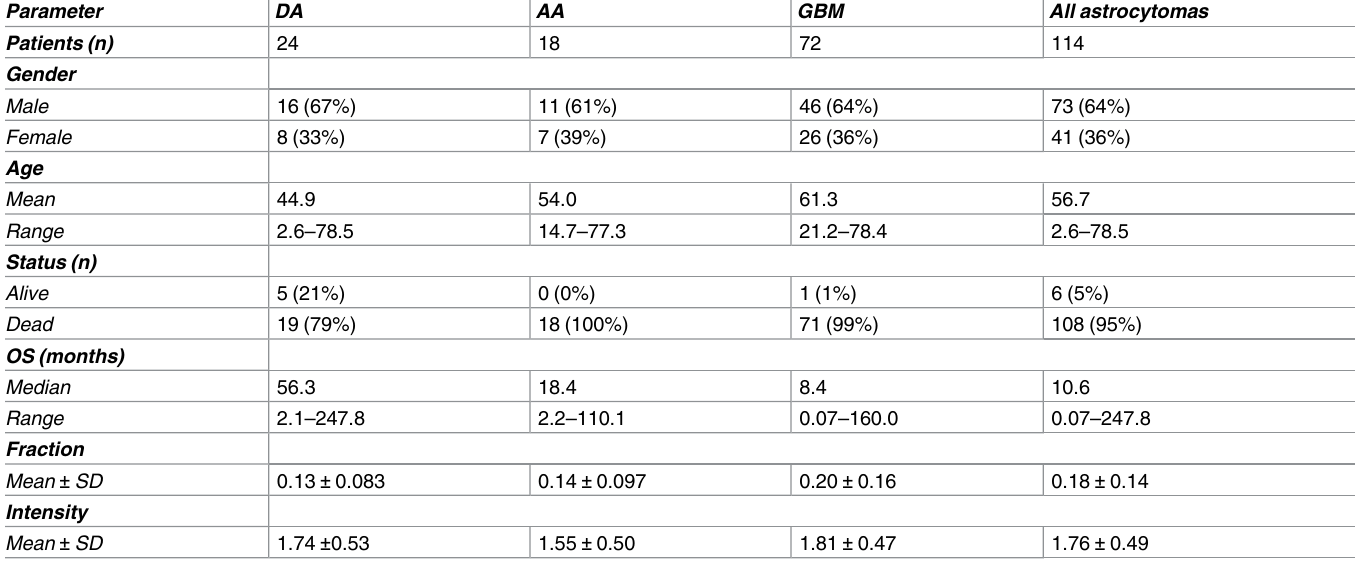
Table 1. Patient characteristics and Oct-4